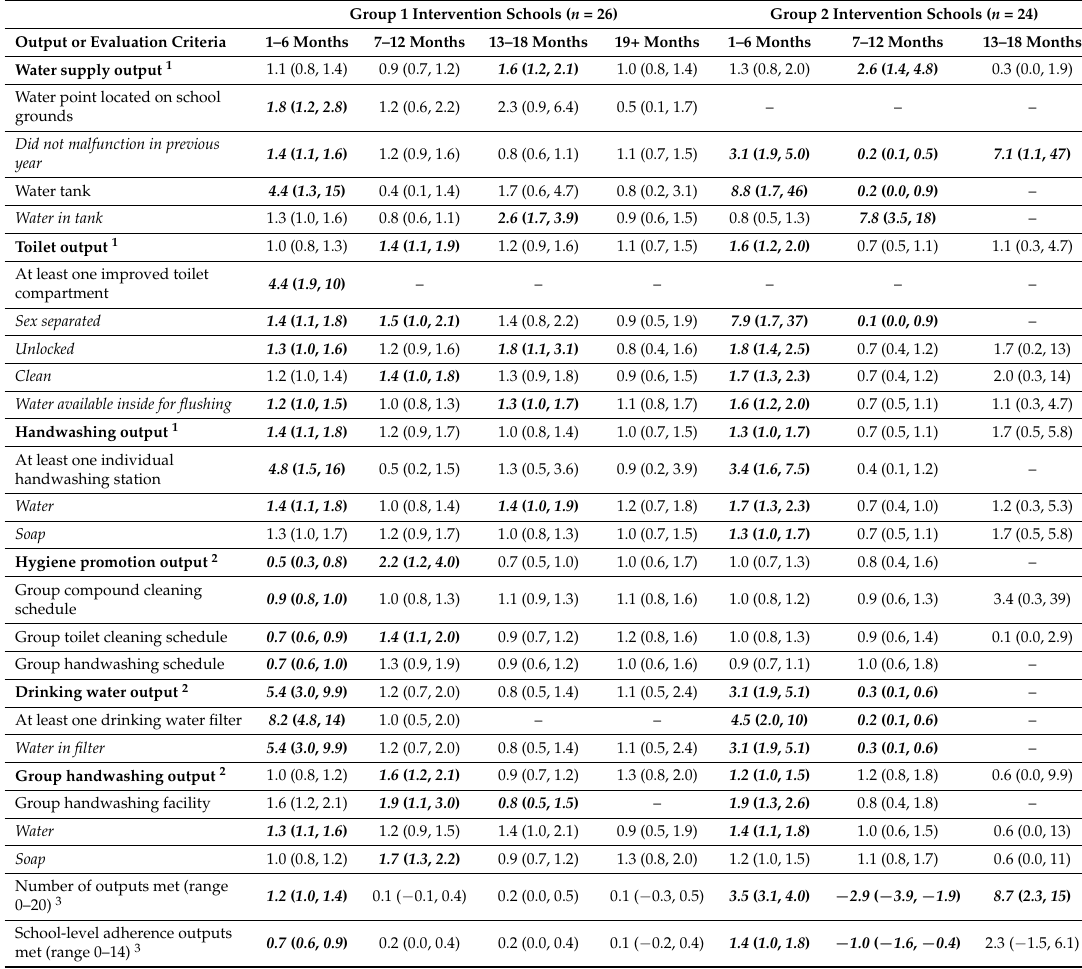
Table 3. Per month change in odds of intervention schools achieving project output or evaluation criteria by time since project